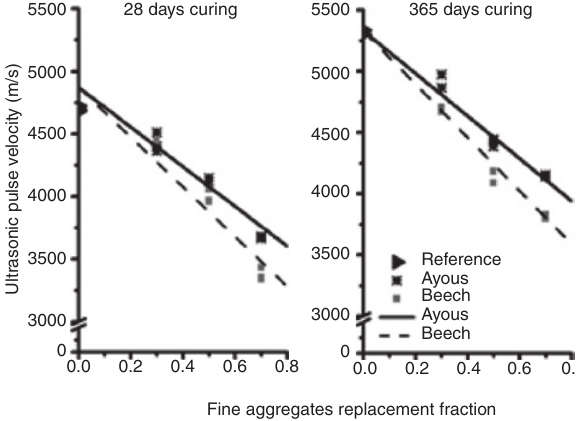
Figure 9: Ultrasonic pulse velocity versus fine aggregates replace- ment